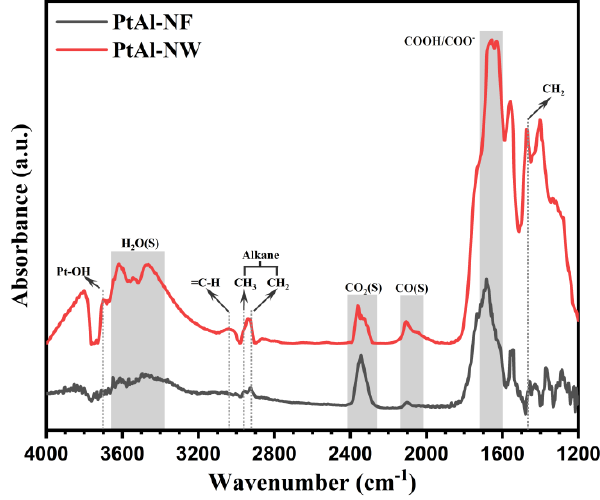
Figure 5. In situ DRIFT spectra over Pt/ γ − Al 2 O 3 at 180 °C. Reaction conditions: 700 ppm C 2 H 4 , 10% O 2 , N 2 balance, 17 mg catalyst, and 50 mL min −1 flow rate. Table 2. Proposed surface reaction steps of C 2 H 4 for Pt/ γ -Al 2 O 3